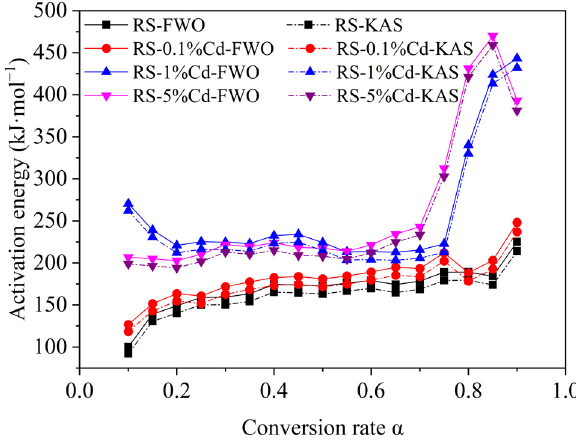
Figure 8. APAE of rice straw with different Cd loading based on FWO method and KAS method. Int. J. Environ. Res. Public Health 2022 , 19 , 8953